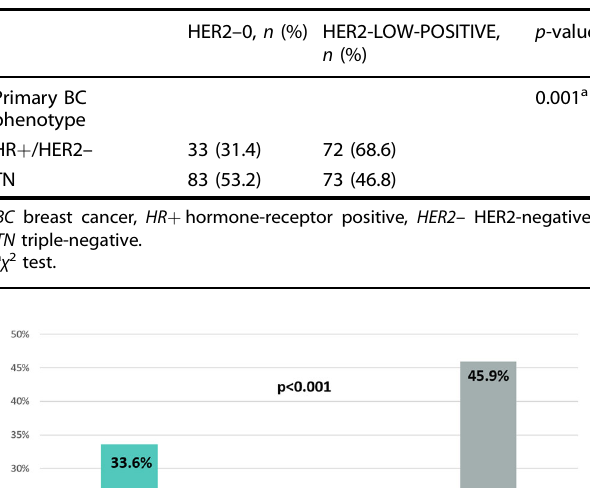
Table 3. Distribution of primary breast cancer phenotype according to HER2 expression.